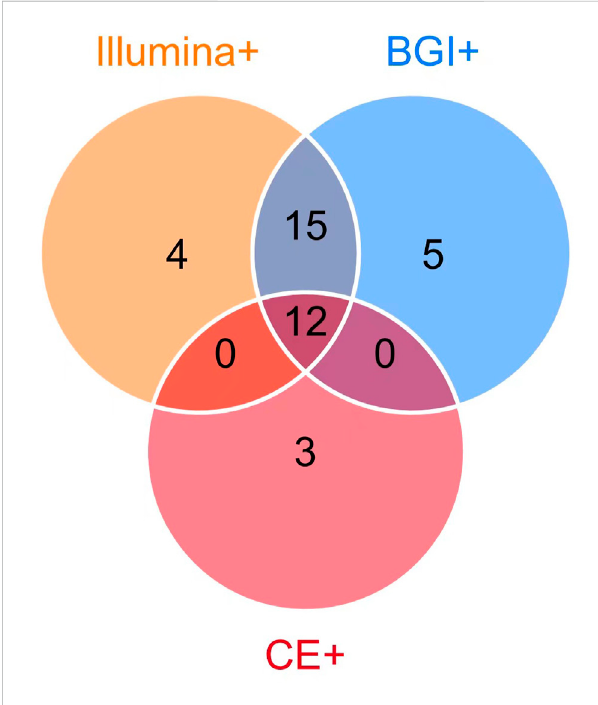
FIGURE 3 Comparison of pathogens detected using mNGS (Illumina and BGI platforms) and CE. Among the 39 patients with identi fi ed pathogens, 15 (38.46%) were diagnosed using CE (pink circle) and 3 (7.69%) using CE only; 36 (92.31%) were diagnosed using mNGS, 32 (82.05%) using the BGI platform (blue circle), 31 (79.49%) using the Illumina platform (orange circle), 12 (30.77%) using mNGS and CE (the overlap of pink, orange, blue circle). The 27 patients (69.23%) were diagnosed using the Illumina and BGI platforms (overlap between orange and blue circle Illumina and BGI platforms), 4 (10.25%) using only the Illumina platform, and 5 (12.82%) using only the BGI platform.